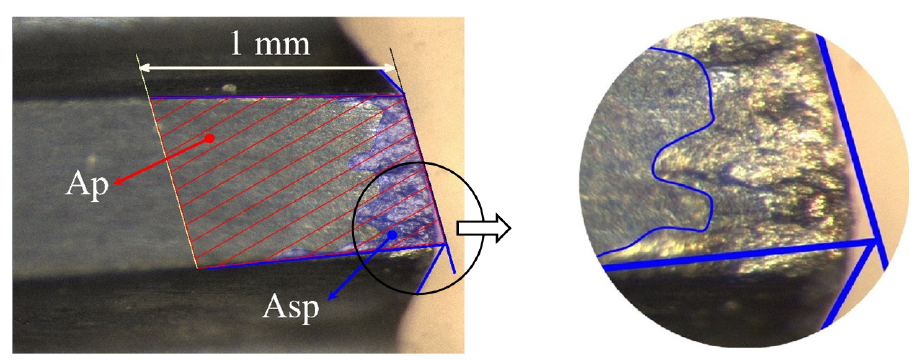
Figure 10. Wear area ( A sp ) and control area ( A p ) parameters on the flank face.